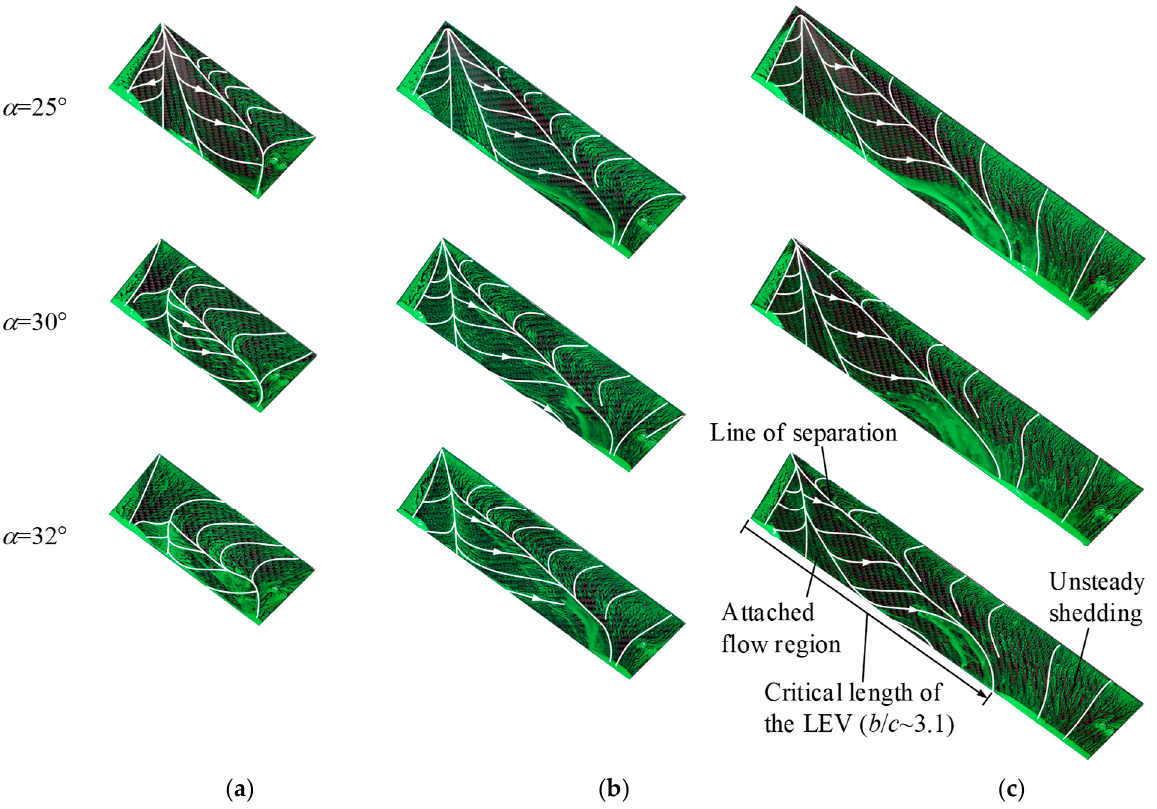
Figure 10. Surface oil-flow pattern near stall α at β = 36 deg. ( a ) AR = 2.03; ( b ) AR = 3.13; ( c ) AR = 4.50.